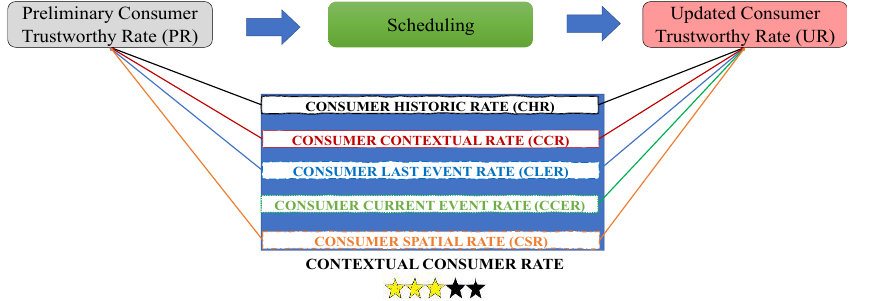
Figure 2. CTR in the scope of the proposed methodology.